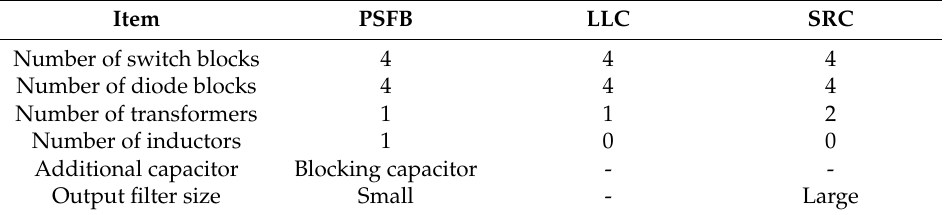
Table 23. Comparison of components used in PSFB, LLC and SRC converter. Adapted from [98].